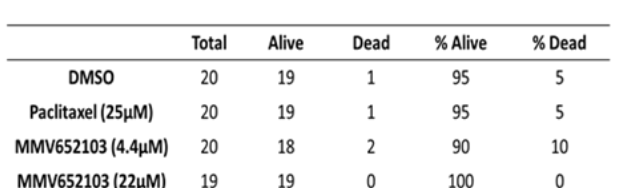
Figure 8: In vivo chick embryo studies of MMV652103. ( A ) Description of the chick embryo study. At day 10 (E10), tumors were detectable. Tumors were treated for a period of 10 days, every 48 h (E10, E12, E14, E16) by dropping 10 μl of vehicle (0.25 % DMSO in PBS), 25 µM Paclitaxel (positive control), and MMV652103 at 4.4 and 22 µM. Subsequent analyses included assessment of tumour growth, metastatic invasion, and toxicity to the embryo. ( B ) Number of dead and surviving embryos for the different experimental groups at E18. ( C ) Mean values ± SEM of tumor weight measured for each experimental group. ( D ) The relative amount of metastases, measured by qPCR for Alu sequences in the lower CAM of groups, compared to negative control (arbitrary value for metastasis set to 1). *p <0.05, **p < 0.01, ***p < 0.001, student’s t